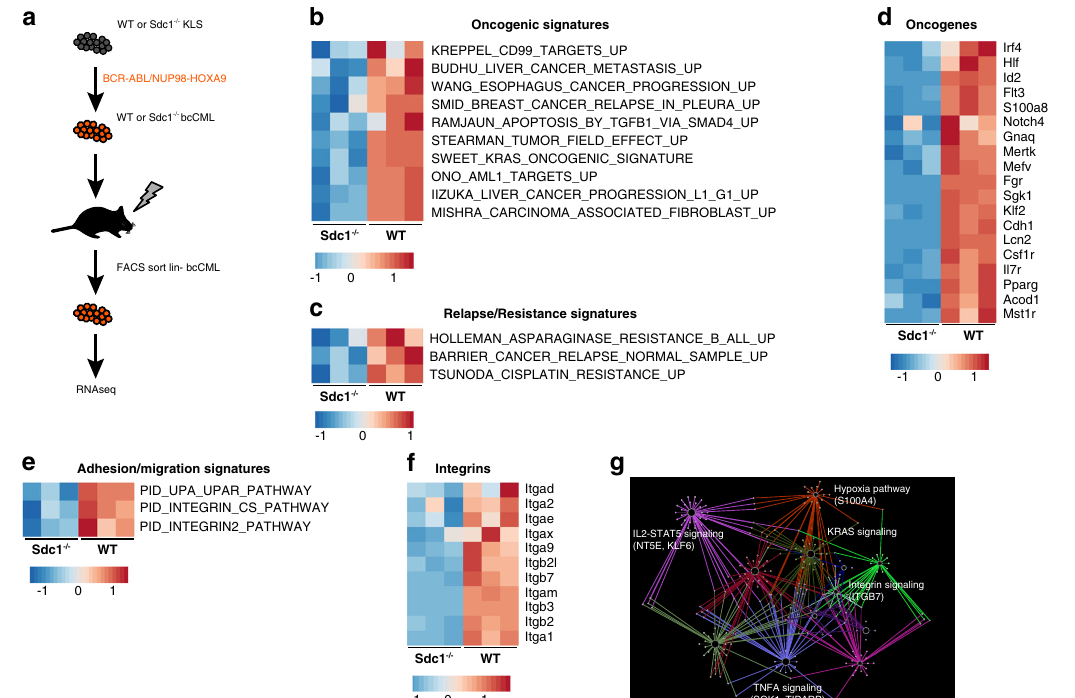
Fig. 8 Syndecan-1 loss disrupts growth and migration programs. a Schematic of RNAseq work fl ow. b GSEA analysis of WT vs. Sdc1 − / − bcCML RNAseq showing impact on oncogenic pathways. c GSEA analysis of WT vs. Sdc1 − / − bcCML RNAseq showing impact on drug resistance/relapse pathways. d Heat map of selected genes falling within the GSEA oncogenic and resistance/relapse pathways. e GSEA analysis of WT vs. Sdc1 − / − bcCML RNAseq showing impact on adhesion/migration pathways. f Heat map of integrin gene expression in Sdc1 − / − bcCML falling within the GSEA adhesion/migration pathways. g Network analysis of genes downregulated in Sdc1 − / − bcCML by RNAseq crossed to a recently published bcCML CRISPR